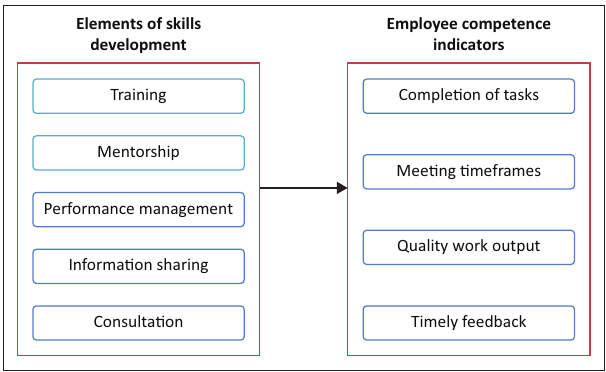
FIGURE 1: A proposed framework for skills development and employee competence for public sector